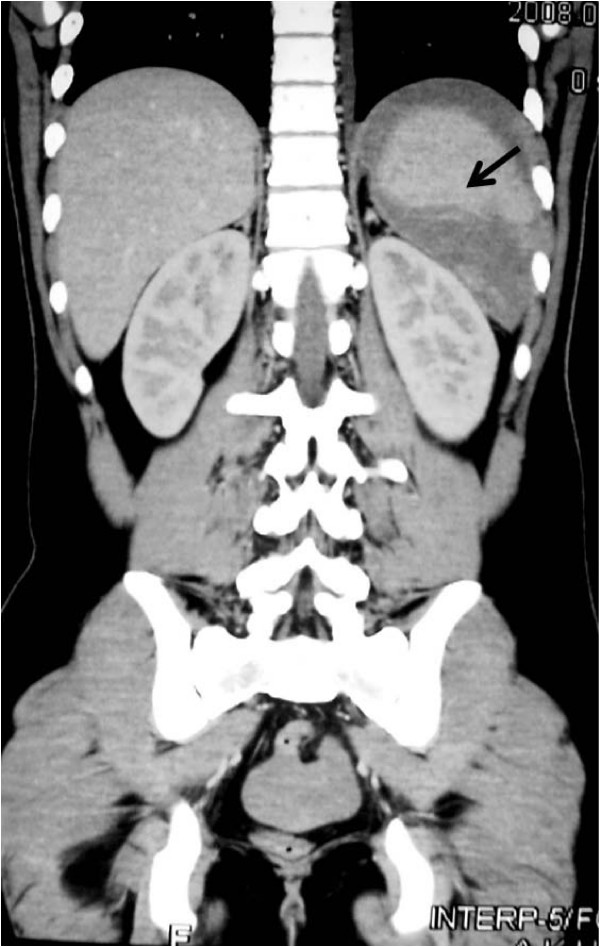
CT SCAN Axial cuts showing peri-splenic fluid collection (bleed) and Niche of rupture (arrow).